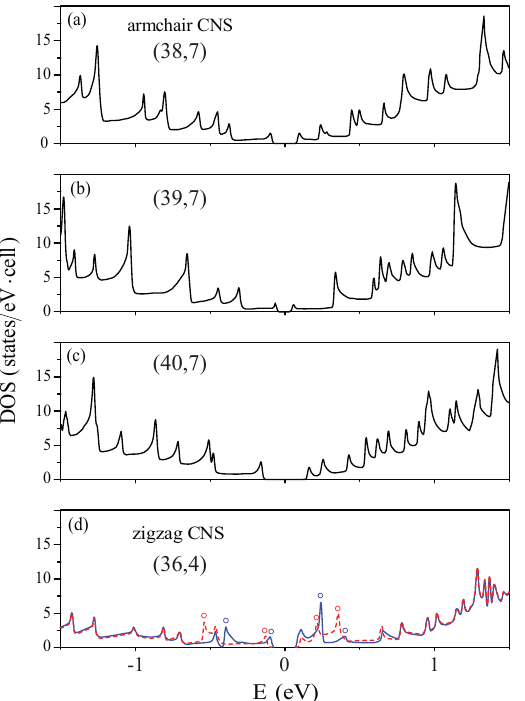
Figure 7. Density of states for the ( a ) (38,7), ( b ) (39,7) and ( c ) (40,7) armchair nanoscrolls, and ( d ) for the (36,4) zigzag